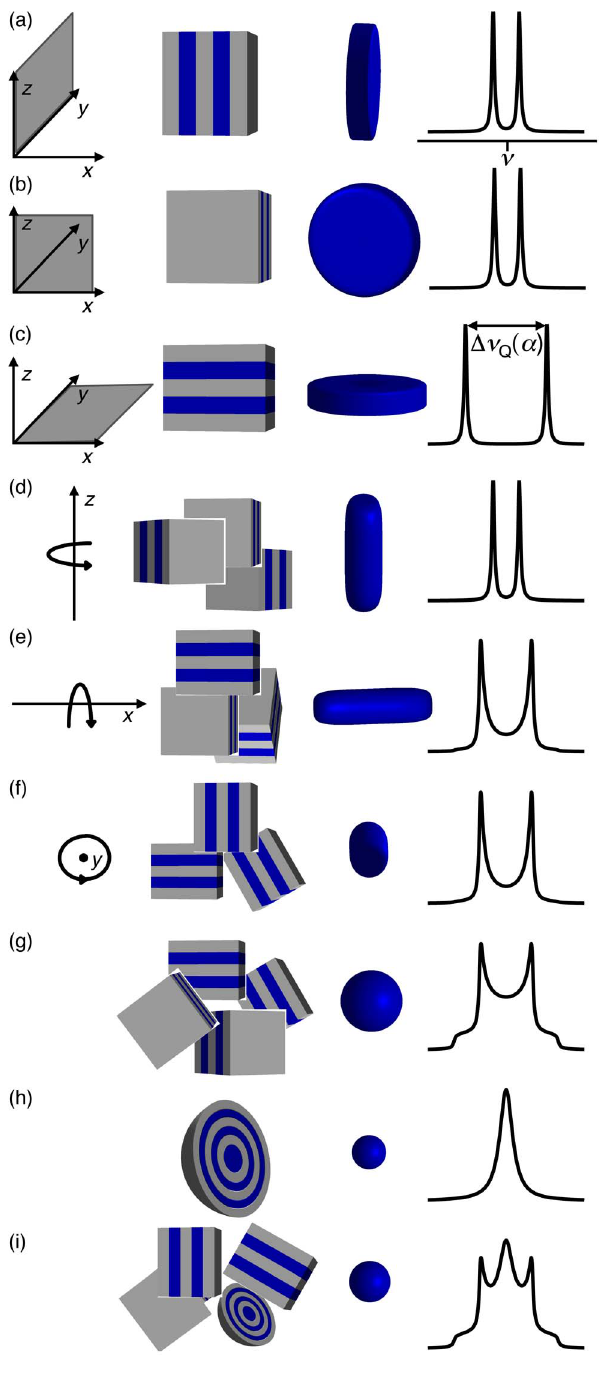
Figure 2. Timing diagrams of the NMR pulse sequences. (a) Diffusion tensor imaging (DTI) pulse sequence based on a 1 H spin echo. Spatial resolution is provided by two phase-encoding gradients in the x and y -directions and frequency-encoding gradient in the z -direction, while the diffusion gradients d encode the images for translational motion. The phase and diffusion gradients are incremented indepen- dently, yielding a 4D experiment with three spatial and one diffusion dimension. The phase of the 180 u RF pulse is cycled in two steps + y . (b) 2 H spectroscopic imaging sequence using a quadrupolar echo and three independently incremented phase-encoding gradients ( x , y and z - direction). The sequence yields a 4D data set with three spatial and one spectral dimension. The RF and receiver (rec) phases are cycled in 4 steps according to w 1 ~ xxyy , w 2 ~ y (cid:2) yyx (cid:2) xx , and w R ~ xxyy .